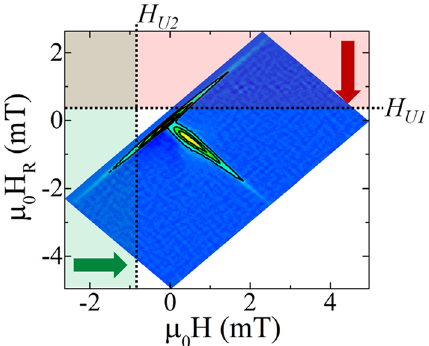
Figure 1. Schematic diagram illustrating the integration approach for recovering a major hysteresis loop from the FORC diagram. The red-shaded region, integrated from the top of the panel down, recovers all of the down- switching events between positive saturation and H U . The green-shaded region, integrated from left to right, recovers all of the up-switching events from negative saturation to H U